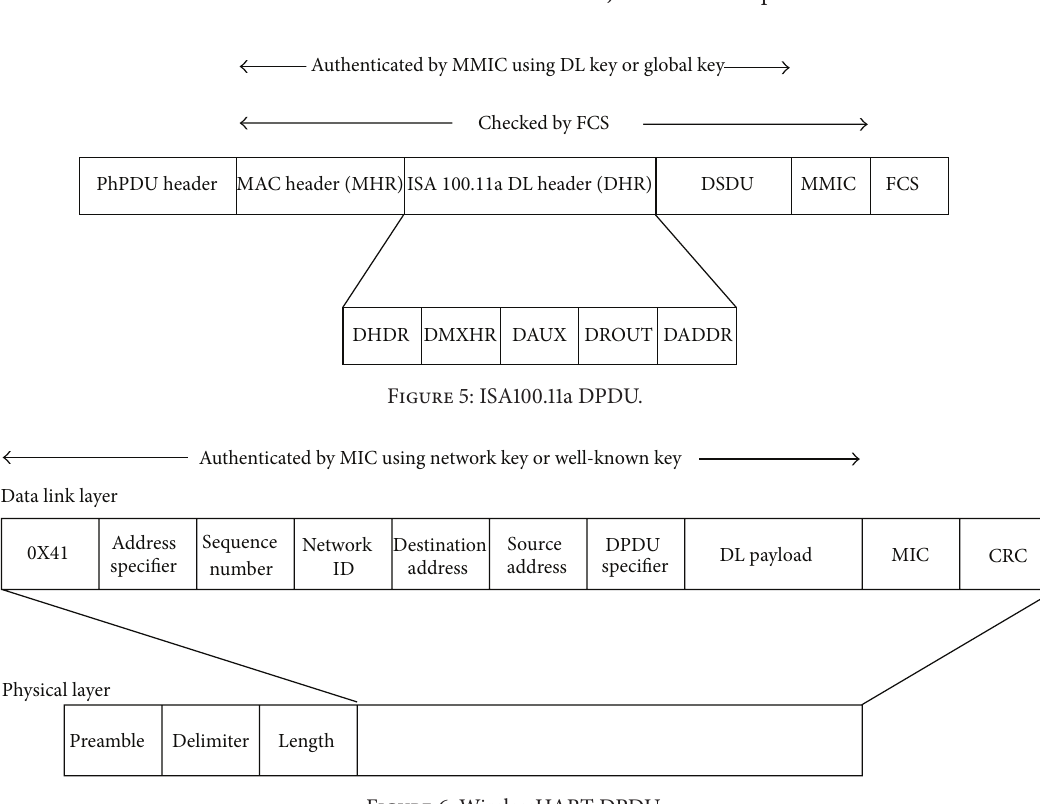
Figure 6: WirelessHART